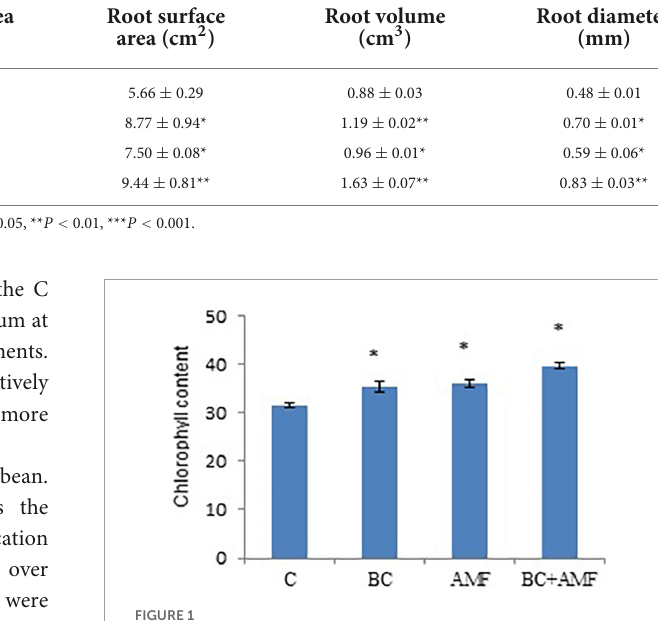
FIGURE1 The chlorophyll content of leaves in soybean as affected by biochar and AMF under drought conditions. C, control; BC, biochar; AMF, arbuscular mycorrhizal fungi; BC + AMF, biochar + arbuscular mycorrhizal fungi. * P = 0.01.